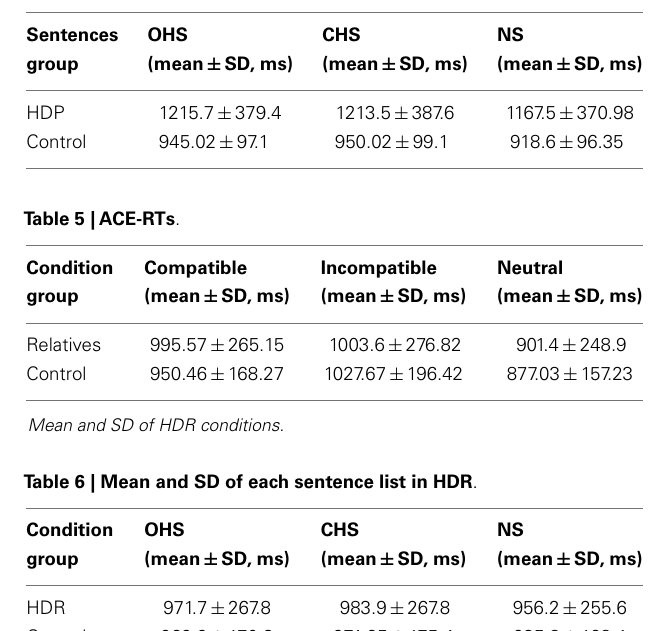
FIGURE 1 |Action compatibility effect in HDP and HDR . (A) Mean RTs from compatible, incompatible, and neutral trials for HDP. HDP did not show an ACE (compatible facilitation and incompatible delay of RTs). (B) ACE subtraction, group comparison of ACE normalized by subtracting mean RT from the neutral trials from the mean RTs from the compatible and incompatible trials. (C) Mean RTs for HDR participants. HDR did not show ACE. (D) ACE subtraction. In all panels, the bars depict the SD.